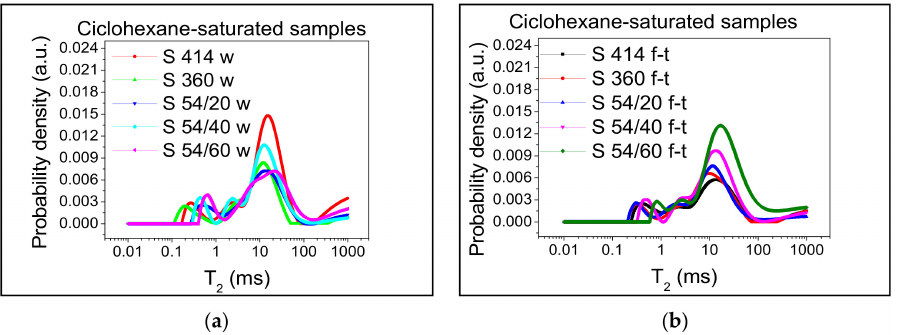
Figure 8. Transverse relaxation time distribution T 2 after cyclohexane saturation: ( a ) control samples